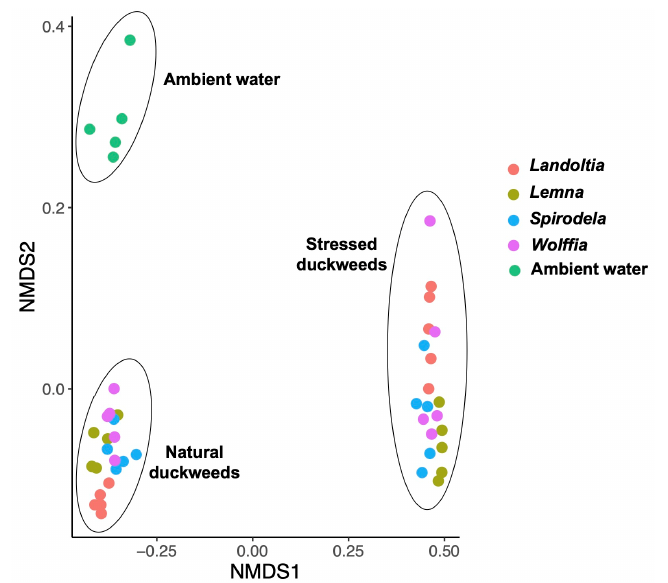
Figure 2. Non-metric multidimensional scaling (nMDS) analysis of the Bray-Curtis dissimilarity index between natural, stressed duckweeds (nutrient deficiency) and ambient water. All conditions displayed significant difference based on PERMANOVA analysis ( p -value <